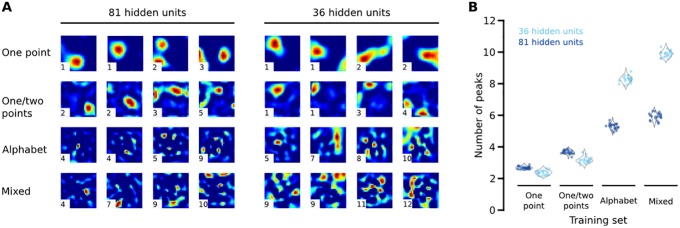
Analysis of receptive fields.(A) Examples of receptive fields learned by the 81- and 36-hidden unit models after training on different training sets (rows). Each receptive field is shown on a 28 x 28 step grid. Heat maps show areas with high weight values, which represent highly sensitive zones. Samples were chosen to show a variety of receptive field morphologies. The number on the bottom left corner of each receptive field is the number of peaks returned by our peak counting algorithm, which measures receptive field complexity. (B) The average complexity of each network under different architectures and training sets. Each data point is the mean peak count of receptive fields from that model on one iteration, with grey violin plots showing the overall frequency distribution across the 20 iterations we performed for each architecture and training set.